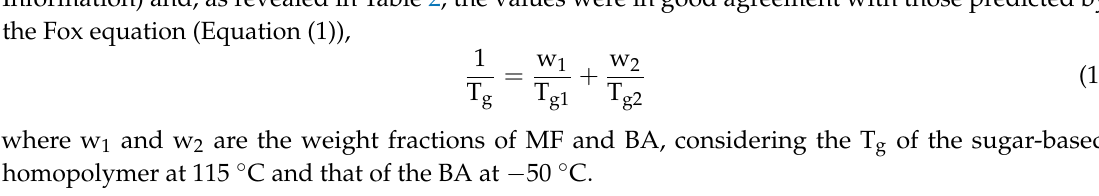
Table 2. Measured and predicted T g of the different methacrylate sugar-based copolymers. Monomer Composition